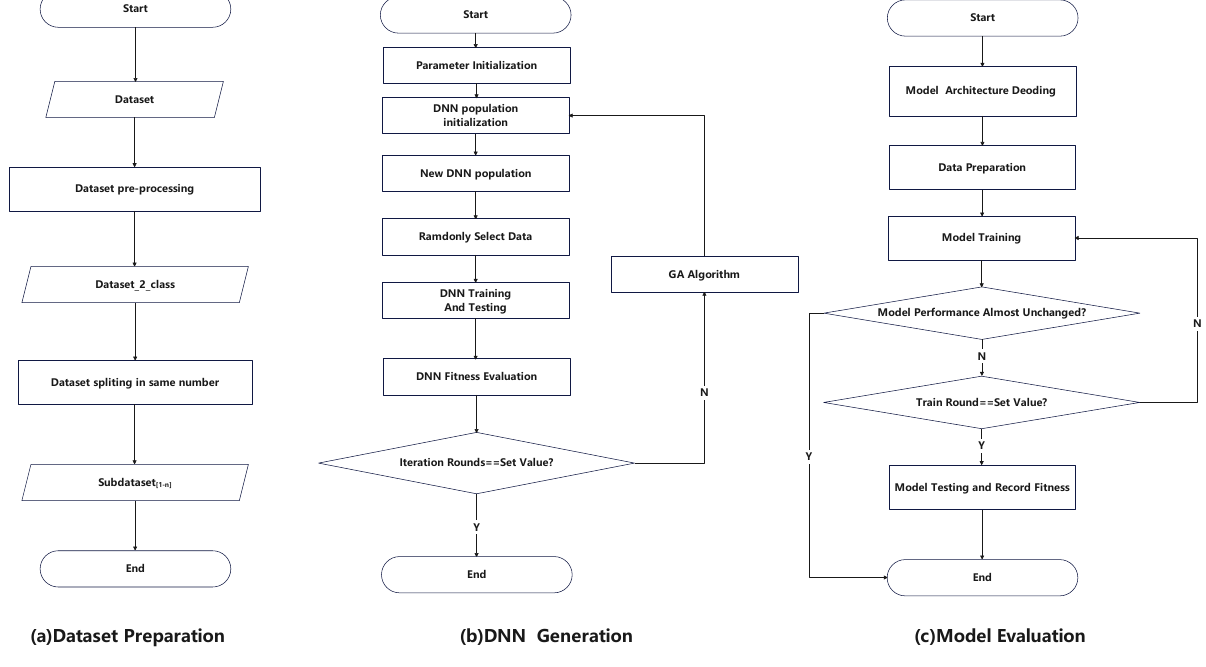
Figure 1. Flowchart of the